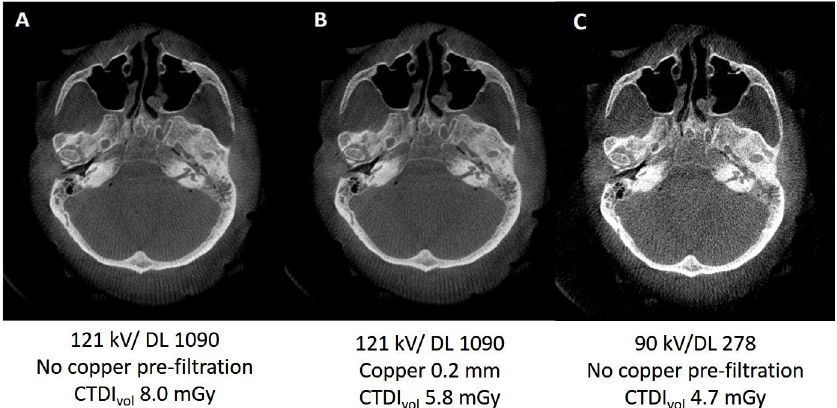
Figure 1. Comparison of datasets (121 kV/ DL 1090) without ( A ) and with 0.2 mm copper pre-filtration ( B ) Axial reconstructed images. Slice thickness 2 mm. No objectifiable difference in image quality. ( C ) For comparison 90 kV/DL 278.